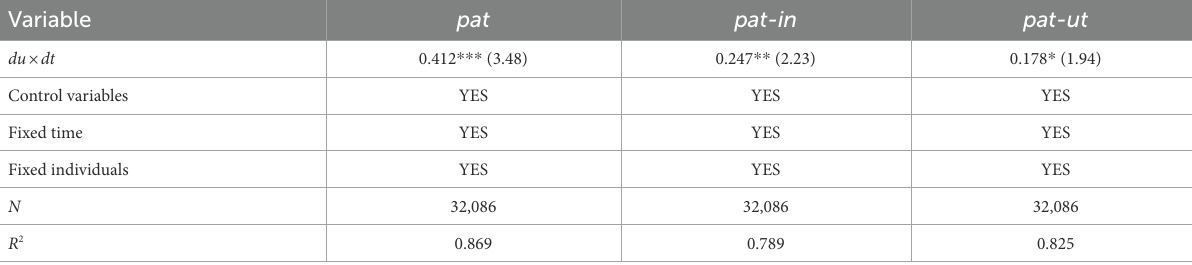
TABLE 2 Regression test results of